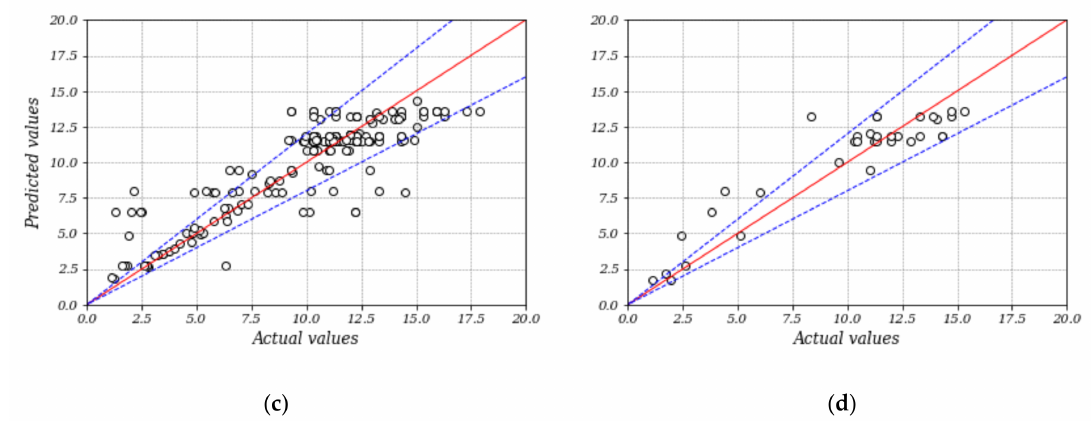
Figure 6. Correlation between estimated and actual values: ( a ) DT: training, ( b ) DT: testing, ( c ) RF: training, and ( d ) RF: testing.